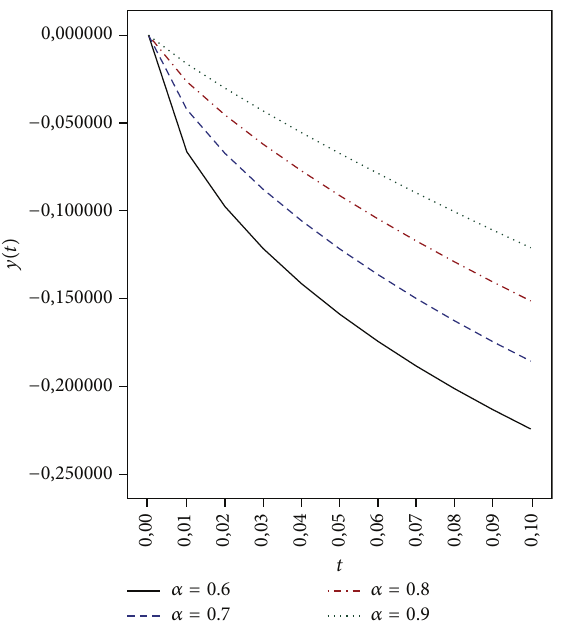
Figure 1: Approximate solutions obtained by GTSM in Example 1 for different order of